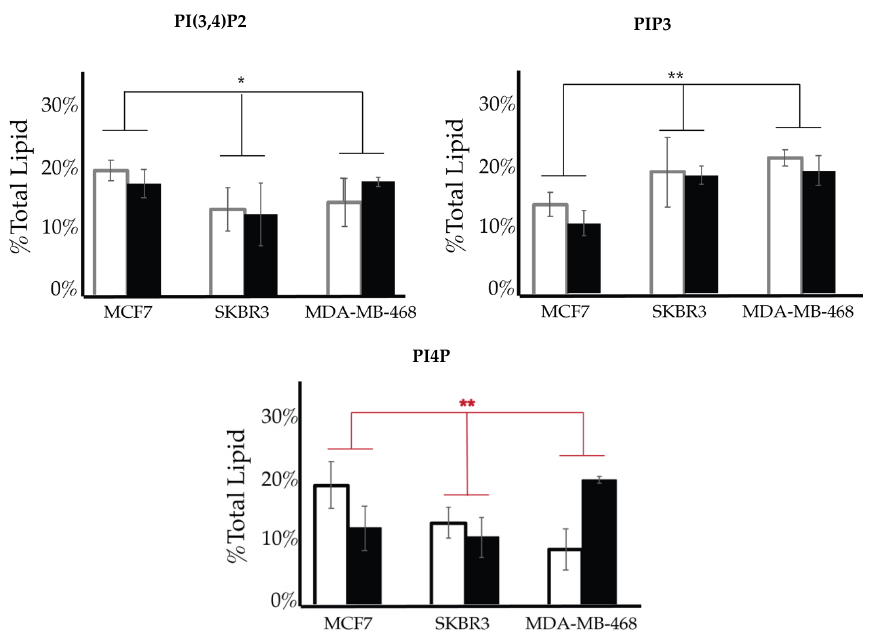
Figure 13. Comparison of whole cell lipidomes across cell types. Comparison of the PI(3,4)P2 and PIP3 content of each of the studied cell lines where the normal ( (cid:114) ) and hyperglycemic ( (cid:121) ) serum conditions led to two-way ANOVA statistically significant di ff erences (* denotes p < 0.05, ** denotes p < 0.005). Additionally, PI4P content had a two-way ANOVA statistically significant interaction e ff ect across cell types suggesting another variable influences their relationship (** denotes p < 0.005).